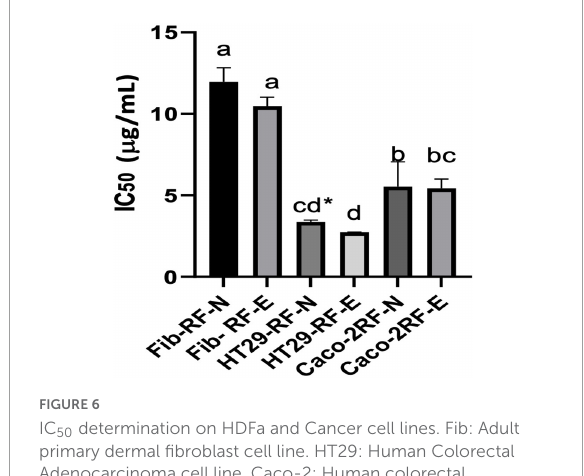
FIGURE6 IC 50 determination on HDFa and Cancer cell lines. Fib: Adult primary dermal fibroblast cell line. HT29: Human Colorectal Adenocarcinoma cell line. Caco-2: Human colorectal adenocarcinoma cell line. Different letter indicates significant differences between IC 50 of different cell lines p < 0.05 by Tukey’s test. * Means significantly differences ( p < 0.05) between strawberry by-product control (RF-N) and: Strawberry by-product biofortified (RF-E) according to t -test p < 0.05.